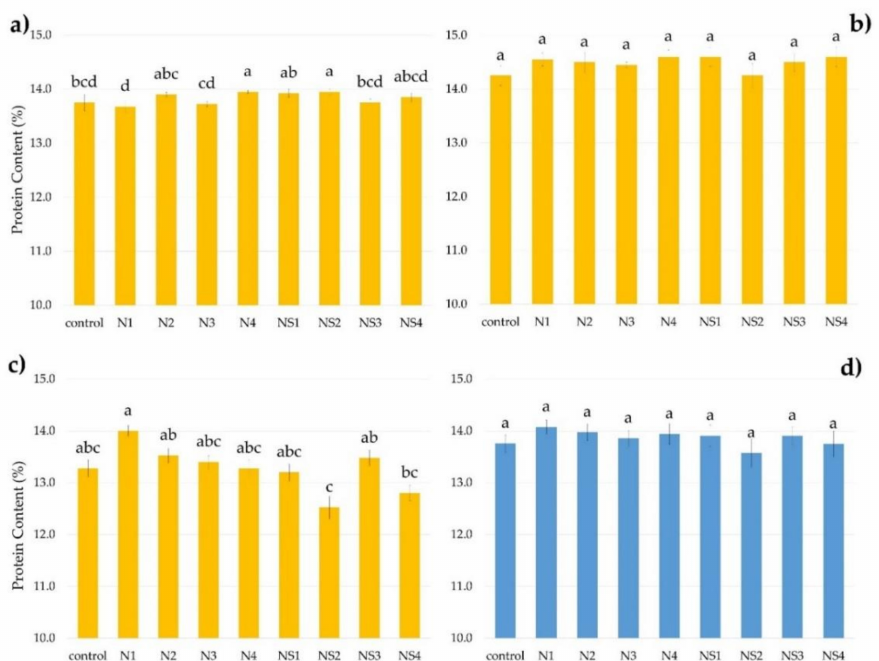
Figure 3. The effect of fertilizer treatments on protein content (%) in the grain, ( a ) growing season 1 (2017–2018), ( b ) growing season 2 (2018–2019), ( c ) growing season 3 (2020–2021), ( d ) average yield. The same letters above the columns describe no statistically significant differences between treatments (LSD test). Each growing season was evaluated separately. Standard error (SE) is expressed by error bars.